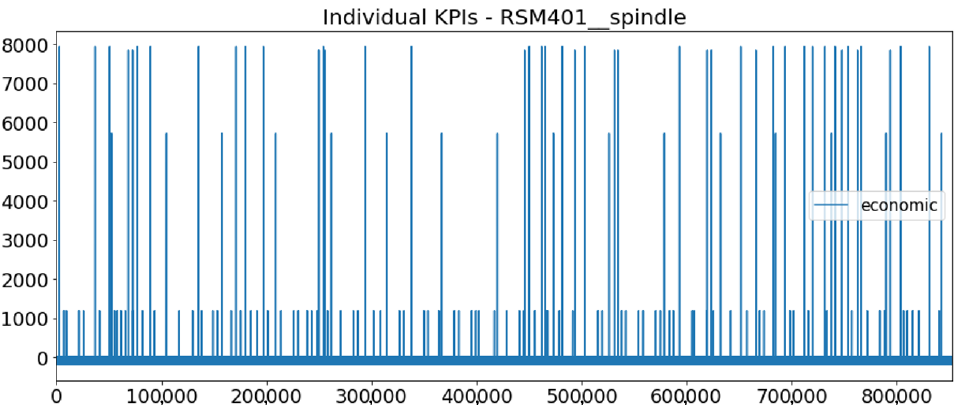
Figure 10. KPI time series for the spindle yielded from running the model for the friction welding machine (HWH). The simulation interval has the same length as for training (292 years).